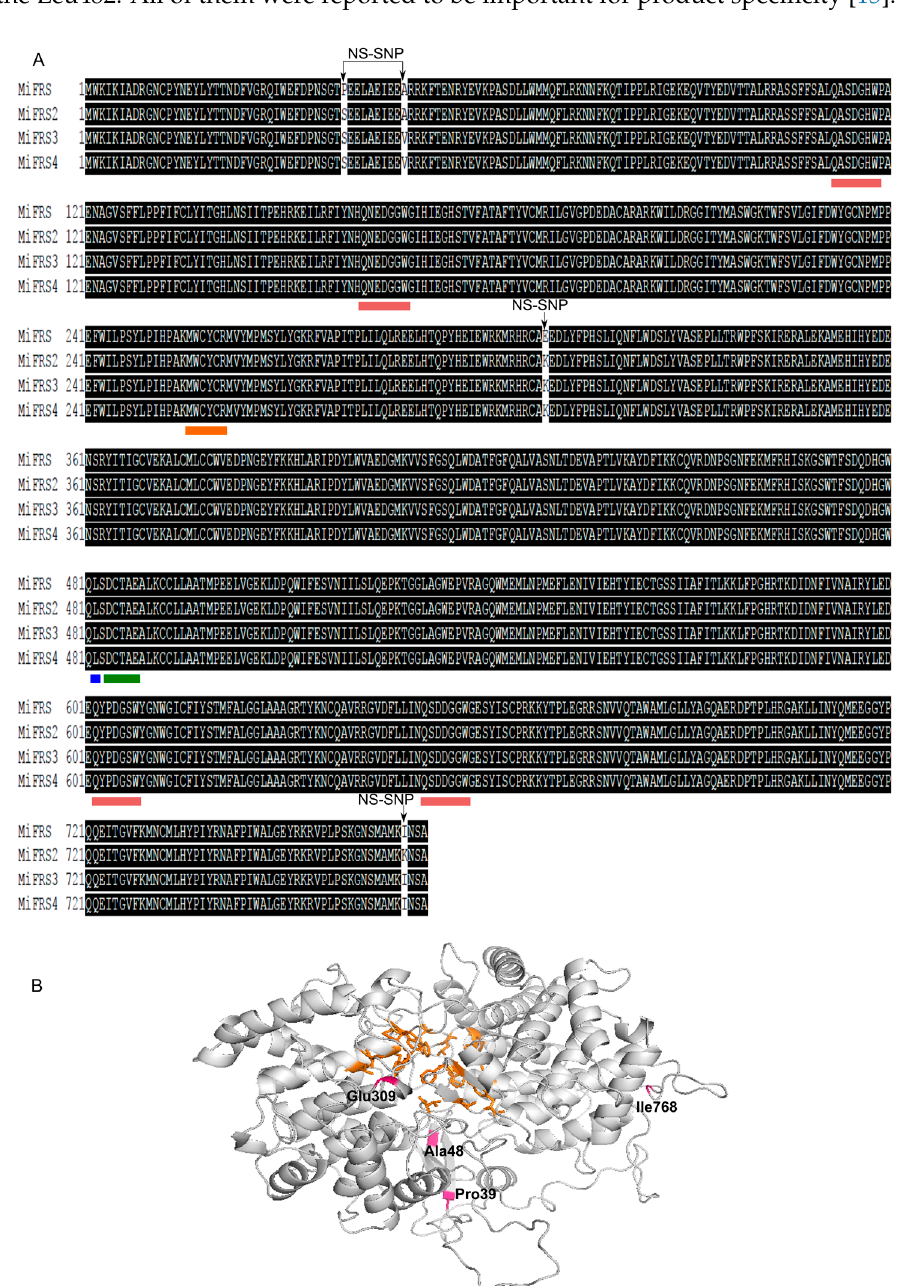
Figure 4. Amino acid sequence and structure of Mi FRS highlighting non-synonymous single nucleotide polymorphisms (NS-SNPS). ( A ) Global alignment of the four sequences cloned for Mi FRS with NS-SNPs shown. Boxes are delimiting the four structure QW-motifs (in pink) and the residues involved in the active site (orange, blue and green); ( B ) Homology model obtained for Mi FRS [15], illustrating that substituted residues (pink) do not interact with residues in the active site (orange).